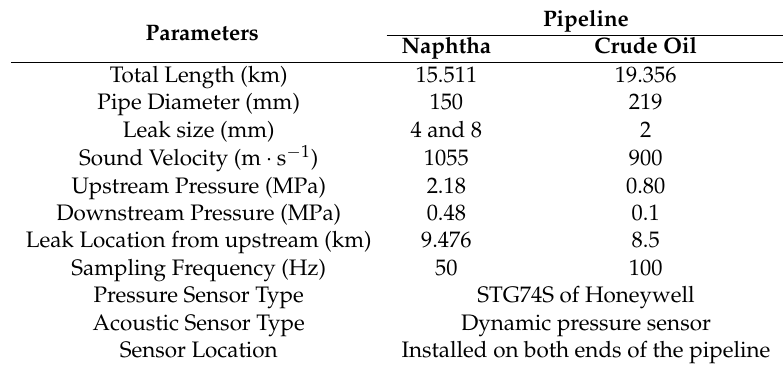
Figure 10. The installation of transducers on pipelines. Table 2. Parameters of the two field